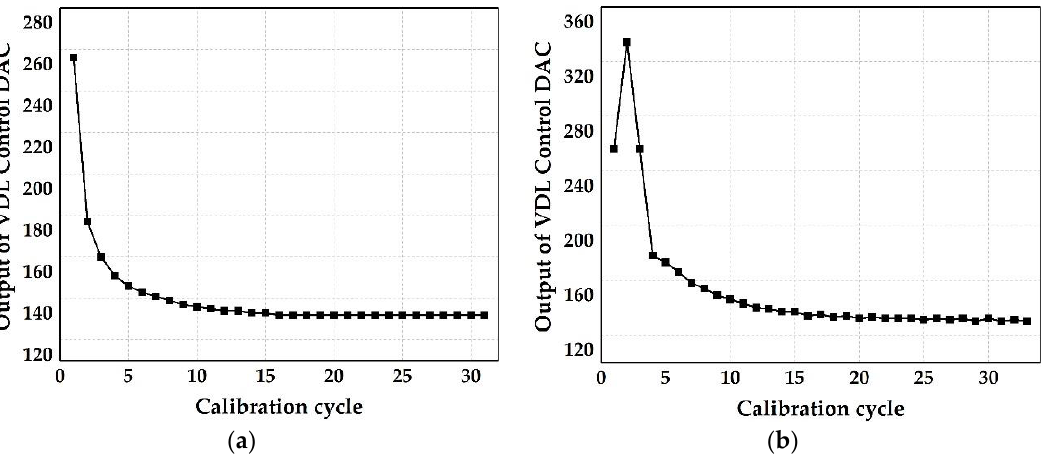
Figure 3. Simulation of calibration convergence ( a ) when the preset for C D is correct in coarse phase and ( b ) when the preset for C D is incorrect in coarse phase.